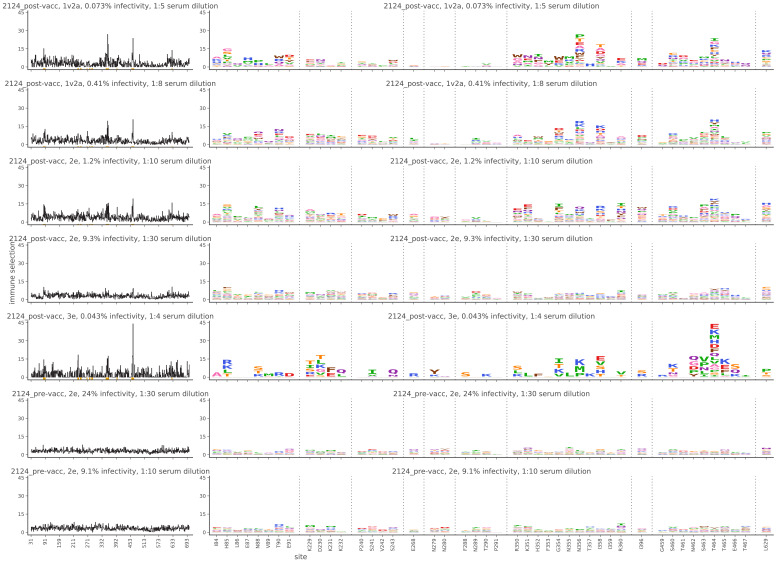
Mutational antigenic profiling data plotted for each individual replicates of pre- and post-immunization sera from rabbit 2124.Data are plotted as in Figure 2A,B for each, but with mutations colored according to their biochemical property rather than epitope.